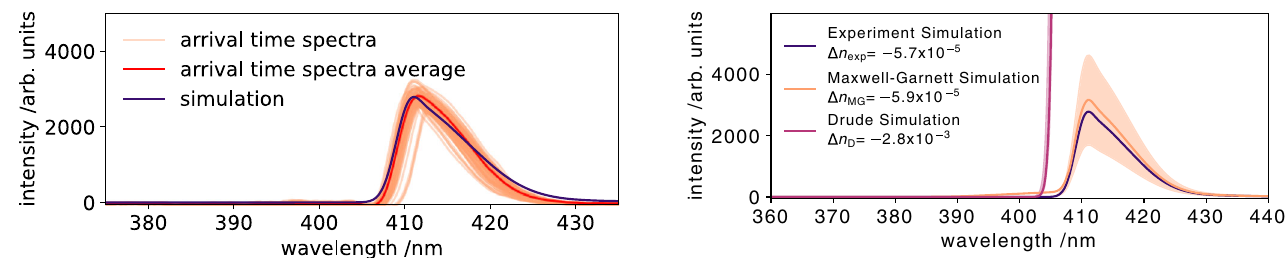
Fig. 7 | Experimentally determined and simulated arrival time spectra. Self- referenced arrival time spectra with the 0.5% highest amplitudes (orange). The average (red) of theses arrival time spectra is used as reference to fi t a simulated (blue) arrival time spectrum to the data. The required X-ray-induced refractive index change to fi t the simulation is Δ n exp = (cid:2) 5 : 7×10 (cid:2) 5 . The horizontal shifts of the individual arrival time spectra are caused by the arrival time jitter, while the fl uctuating amplitudes are caused by the X-ray pointing instabilities.